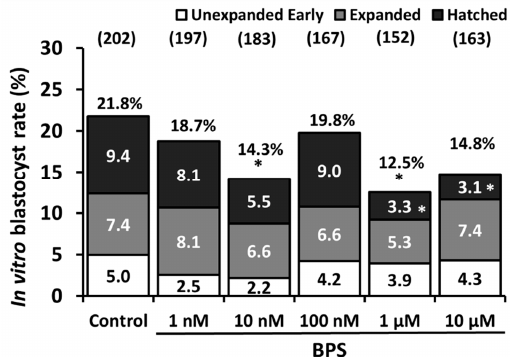
Figure 2. E ff ect of Bisphenol S (BPS) during in vitro maturation (IVM) on the blastocyst rate. Oocytes underwent IVM in the presence or absence of BPS (1 nM, 10 nM, 100 nM, 1 µ M or 10 µ M). Oocytes were then subjected to in vitro fertilisation (IVF), and the blastocyst rates were assessed 7 days after IVF. Blastocysts were classified as unexpanded early, expanded or hatched. Raw percentages were derived from the number of blastocysts normalised to the number of cleaved embryos at day 2. The results from eight independent experiments are expressed as the raw percentage of embryos at each developmental stage. * indicates a significant di ff erence for a given stage compared with the control ( p ≤ 0.05). Numbers of cleaved embryos at day 2 are indicated between parentheses.